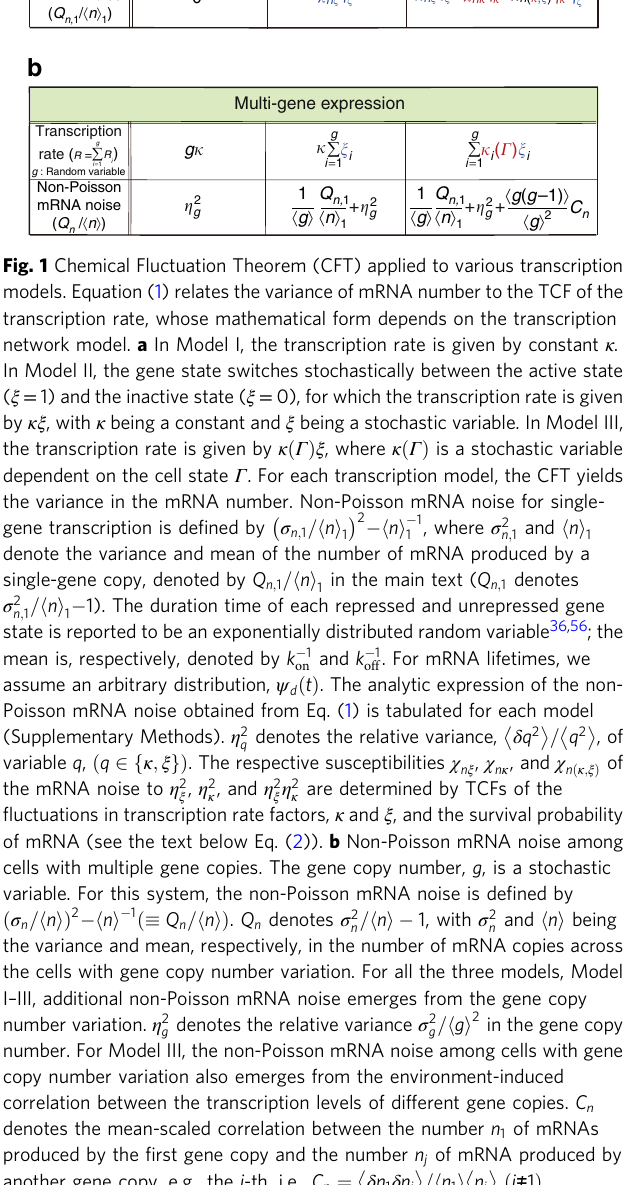
uctuations in transcription rate factors, κ and ξ , and the survival probability of mRNA (see the text below Eq. (2)). b Non-Poisson mRNA noise among cells with multiple gene copies. The gene copy number, g , is a stochastic variable. For this system, the non-Poisson mRNA noise is de fi ned by σ the variance and mean, respectively, in the number of mRNA copies across the cells with gene copy number variation. For all the three models, Model I – III, additional non-Poisson mRNA noise emerges from the gene copy = g h i 2 in the gene copy number variation. η 2 denotes the relative variance σ 2 g g number. For Model III, the non-Poisson mRNA noise among cells with gene copy number variation also emerges from the environment-induced correlation between the transcription levels of different gene copies. C n denotes the mean-scaled correlation between the number n 1 of mRNAs produced by the fi rst gene copy and the number n j of mRNA produced by another gene copy, e.g., the j -th, i.e., C n ¼ δ n 1 δ n j